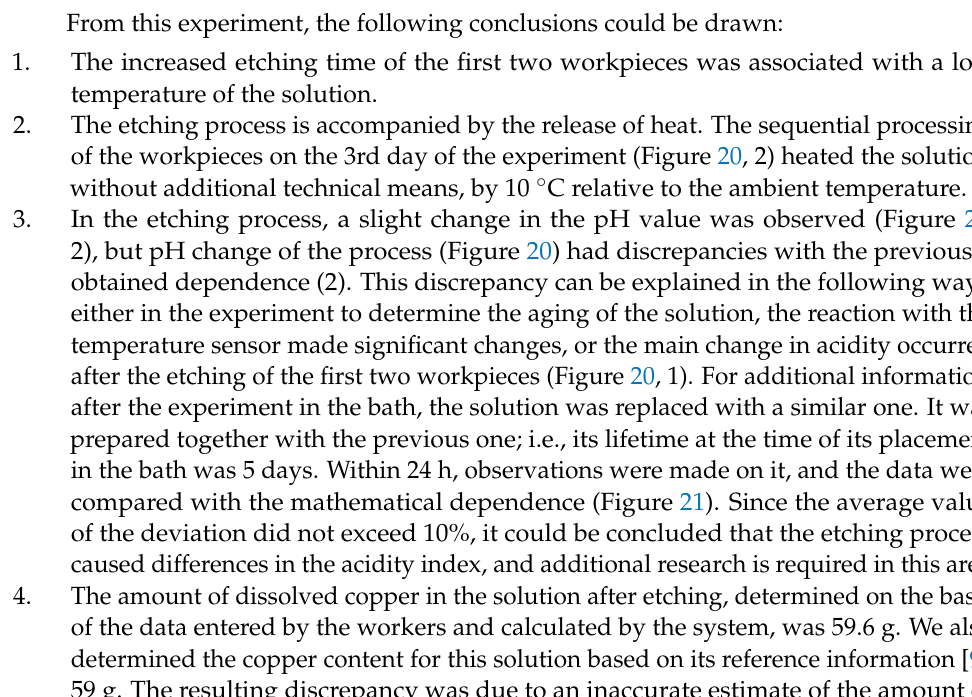
Figure 19. Dependence of the etching time of the workpiece on its etching